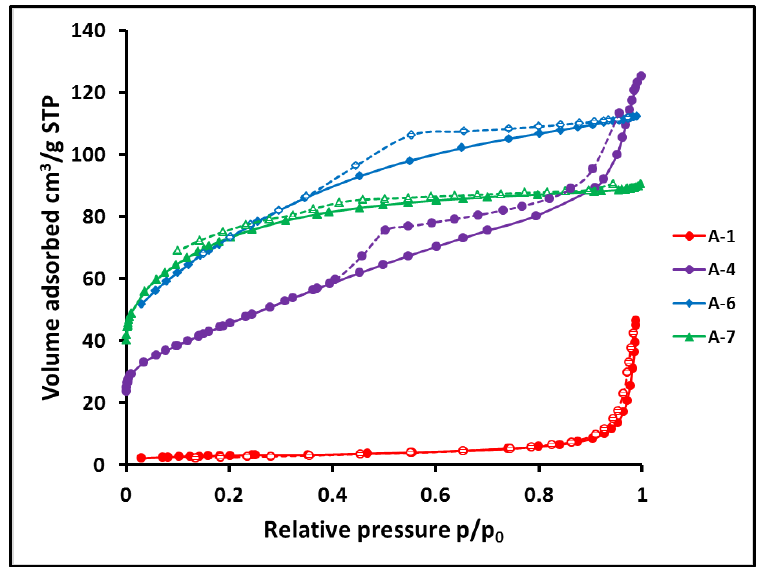
Figure 9. Isotherms of N 2 adsorption of representative ceramic microspheres, DVB/PHMS w / w ratio: A-1 = 0.17, A-4 = 0.65, A-6, A-7 = 0.97.